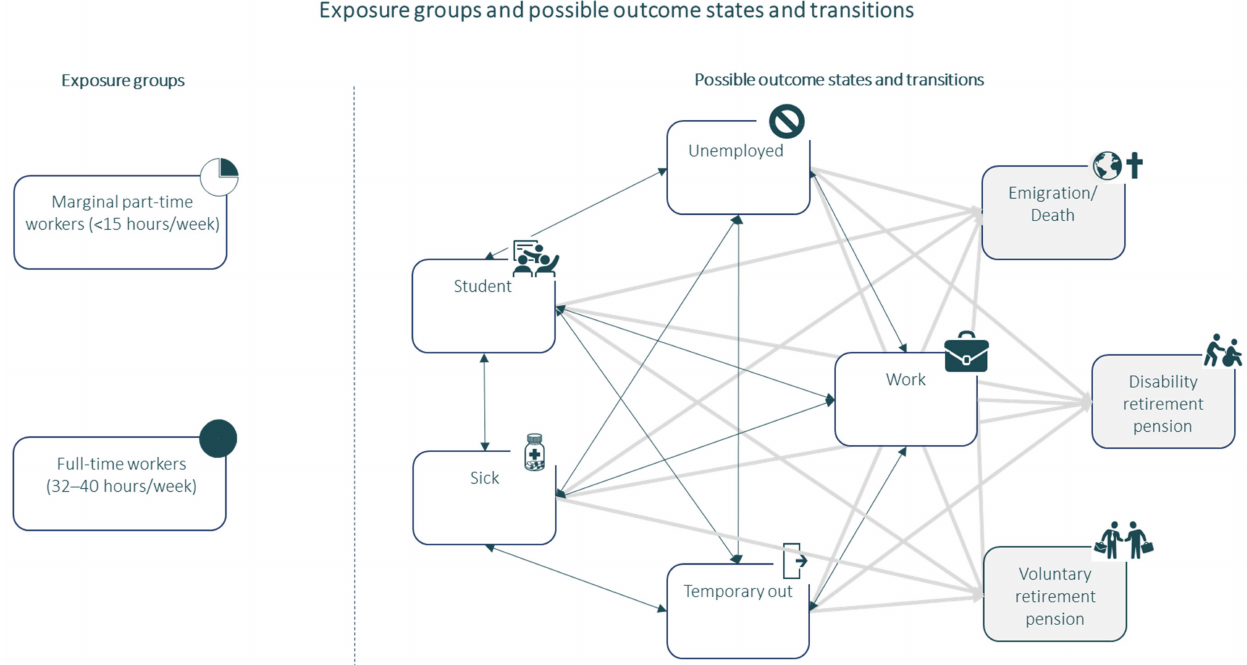
Figure 2. Exposure groups and possible outcome states and transitions. Work = Salary pay- ments, without any social benefits, Temporary out = Parental leave and periods without any reg- istered income, Unemployment = Person available for the labor market receiving social benefit for unemployment, Student = Persons under education, Sickness absence = Long-term sick-listed (>30 consecutive days) receiving sickness absence benefits, Voluntary retirement pension = Time after voluntary retirement (censoring state), Disability retirement pension (Including flex job) = Time after awarded disability pension due to e.g. chronic illness (absorbing state), Emigration or death (censoring state). = Two-way transition. = One-way transition. = recurrent stage. = absorbing/censoring